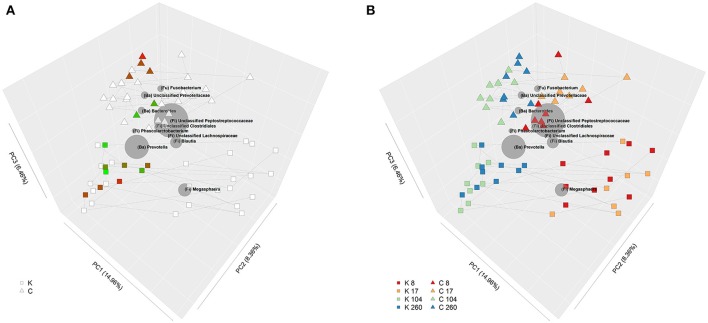
(A) Bi-plot showing principle coordinate analysis (PCoA) of unweighted Unifrac phylogenetic distances of fecal communities in domestic cats (Felis catus) fed either canned or kibbled diets at 8, 17, 104, and 260 weeks of age. Shape indicates diet; square (kibbled; K), triangle (canned; C). Color of squares and triangles represent insulin sensitivity with green representing low insulin sensitivity and red high insulin sensitivity. Lines join samples from the same cat. (B) Bi-plot showing PCoA of unweighted Unifrac phylogenetic distances of fecal communities in domestic cats (Felis catus) fed either canned or kibbled diets at 8, 17, 104, and 260 weeks of age. Shape indicates diet; square (kibbled; K), triangle (canned; C). Color of squares and triangles indicate age; red (week 8), orange (week 17), green (week 104), blue (week 260). Lines join samples from the same cat. Size of gray spheres, representing taxa, are proportional to the average relative abundance across all samples. Position of gray spheres relative to samples indicate their degree of correlation between taxa and samples; i.e., the closer the taxon is to particular samples, the higher the relative abundance of that taxon in those samples.